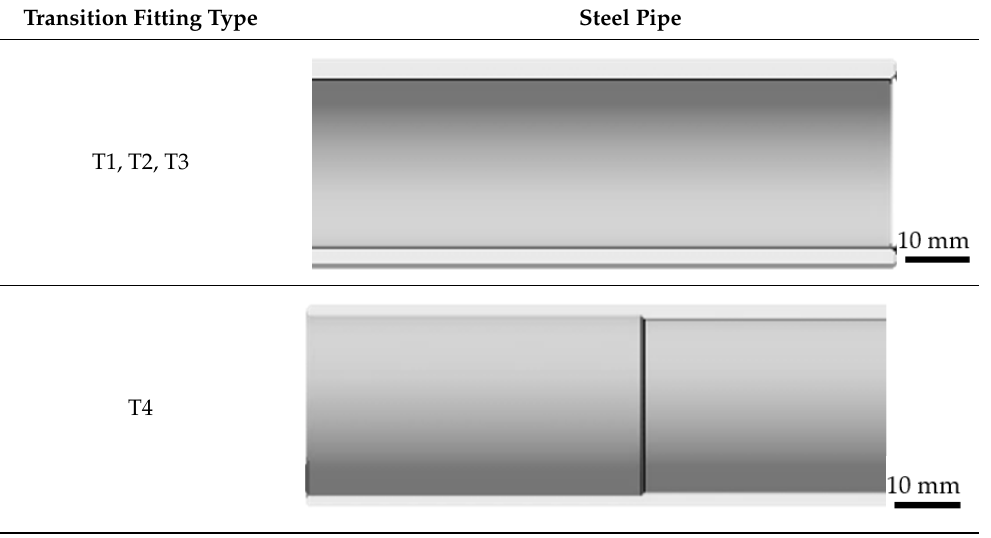
Table 7. The constructive shape of the steel pipe.